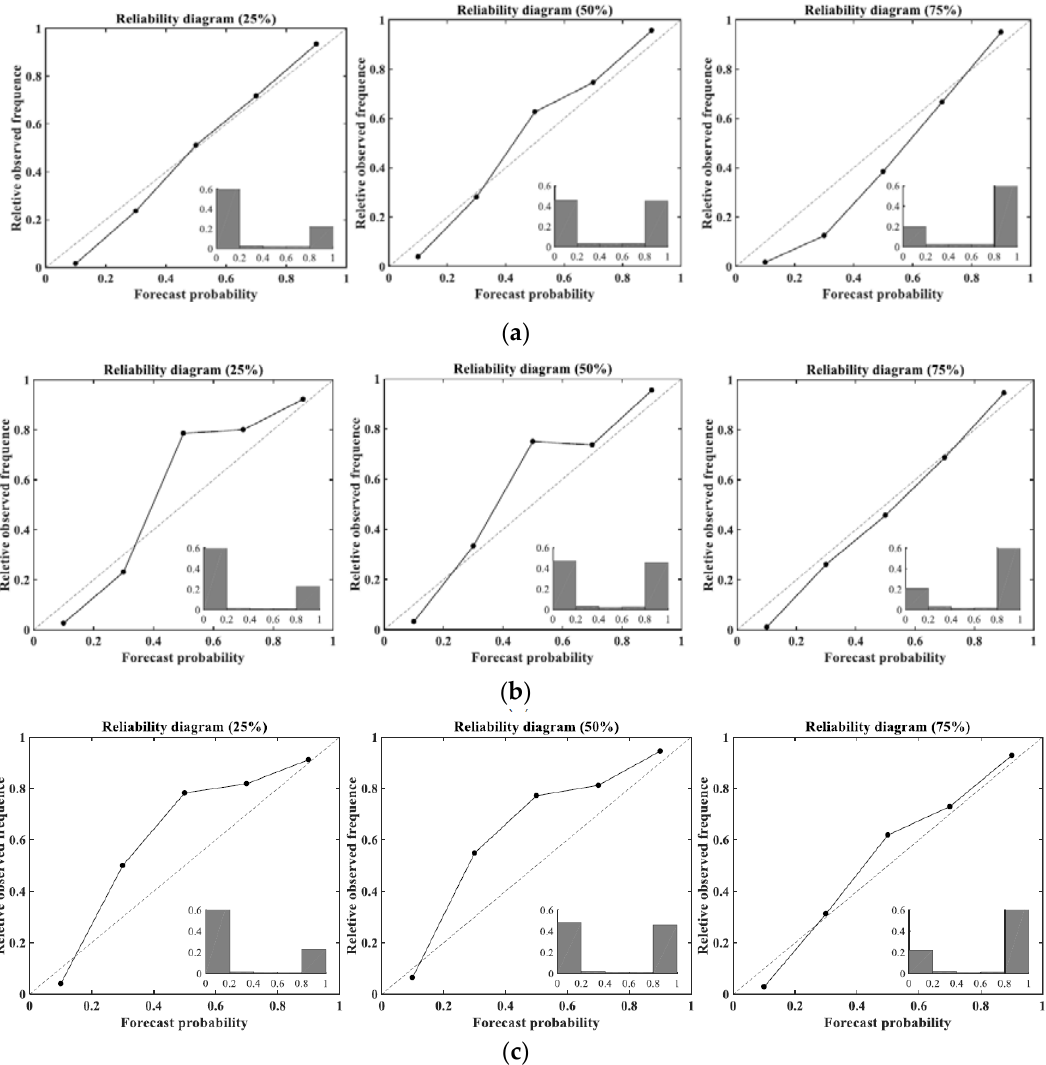
Figure 5. Reliability diagrams for an event smaller than the 25%, 50%, or 75% of historical flows obtained by: ( a ) VBNN, ( b ) GPR, ( c ) HMM.